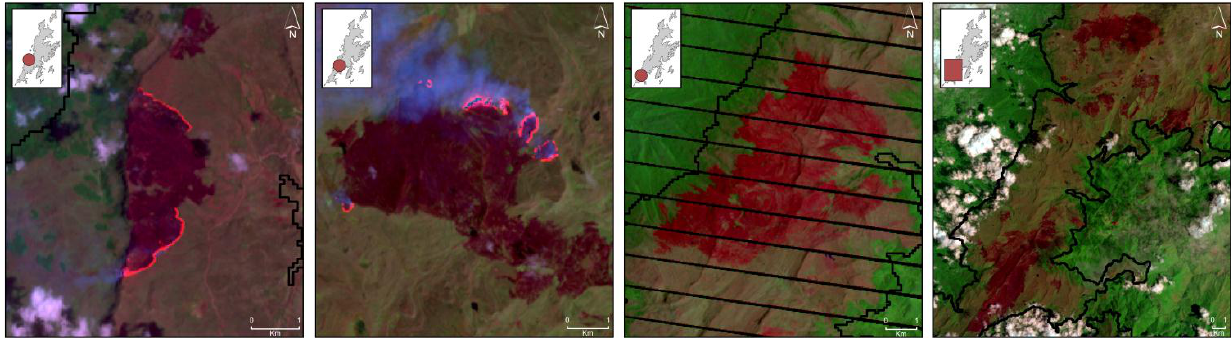
Figure 10. Landsat ETM+ images from southern Sumapaz paramo showing fresh fire scars (( a ) image 25 January 2002) and the vegetation status four months later (( b ) image 21 June 2002).